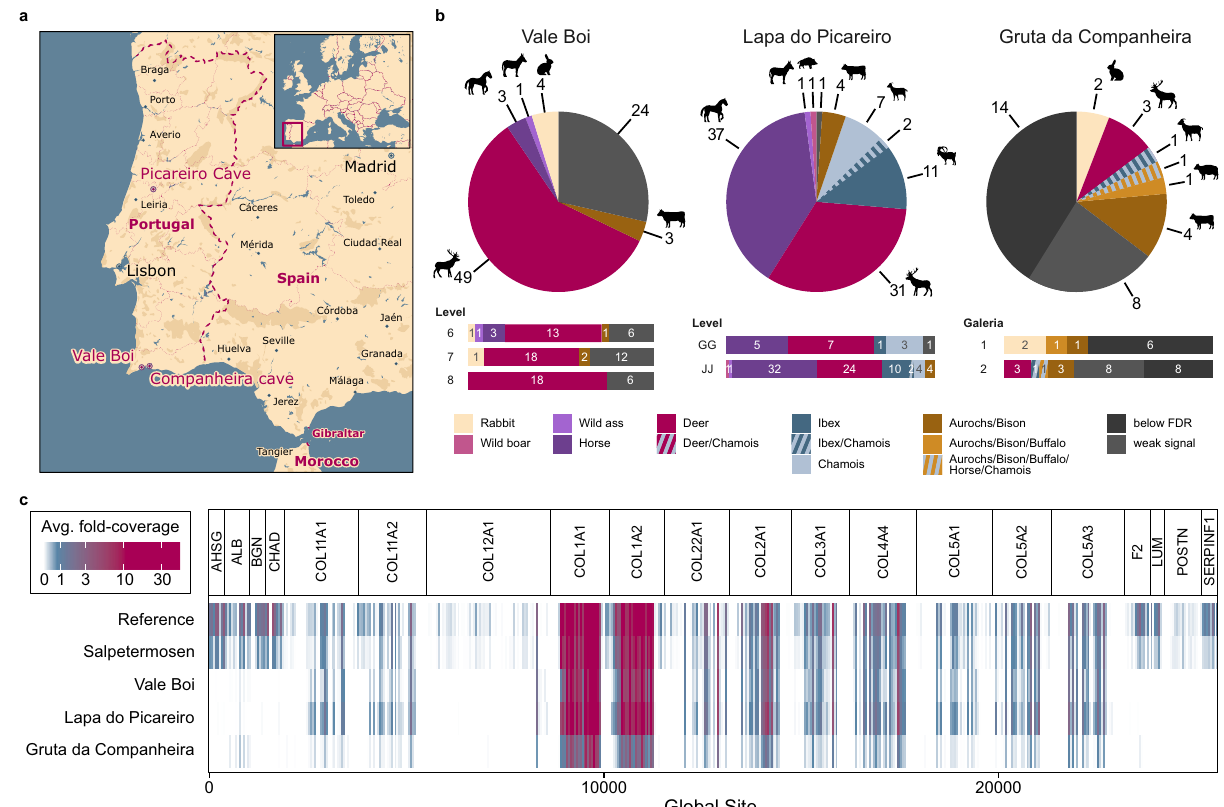
Fig. 5 Large-scale species identi fi cation at three sites with early human occupation on the Iberian peninsula. a Locations of the three sites on a current map of Portugal. Map drawn in Mapbox Studio using a custom style. b Species identi fi ed in 84 samples from levels 6 – 7 (29 – 31,500 BP) of Vale Boi, in 95 samples from layers GG to JJ (38 – 45,000 BP) of Lapa do Picareiro, and 34 samples from chambers 1 and 2 (estimated 50 – 60,000 BP) of Gruta da Companheira. Overall species distribution is displayed by the pie chart, whereas bar charts show species ratios for separate compartments of the assemblage. Colors are used to distinguish species, as indicated in the legend. c Average fold-coverage of the 20 genes used for SPIN comparing the three Portuguese sites with the modern reference and iron-age material. Coverage was calculated by summing the number of precursors at each site in the global aligned database and is indicated by color using white for no coverage, blue for medium coverage, and pink for high coverage. The values represent the average fold-coverage in 10 amino acid bins for each